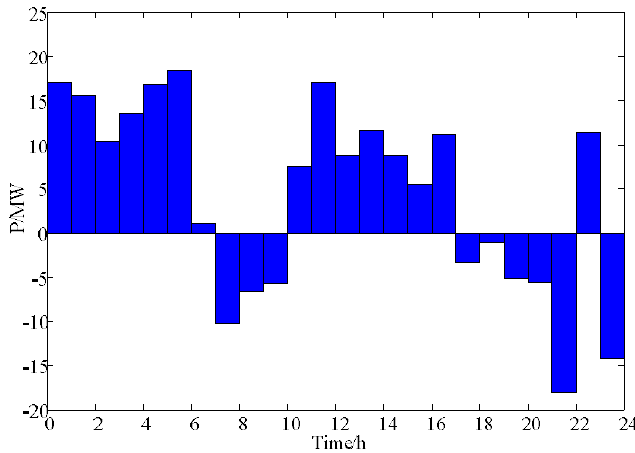
Figure 9. Charging/discharging schedule of the centralized charging station.